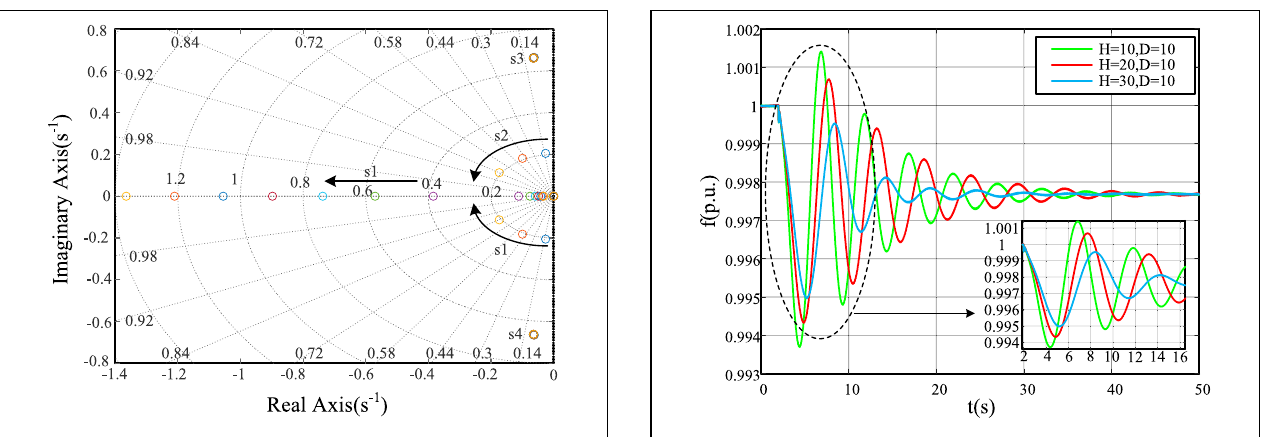
FIGURE 15 | Eigenvalues when H = 20 and D changes. FIGURE 16 | Frequency of the parallel inverter with the virtual inertial time constant changing.